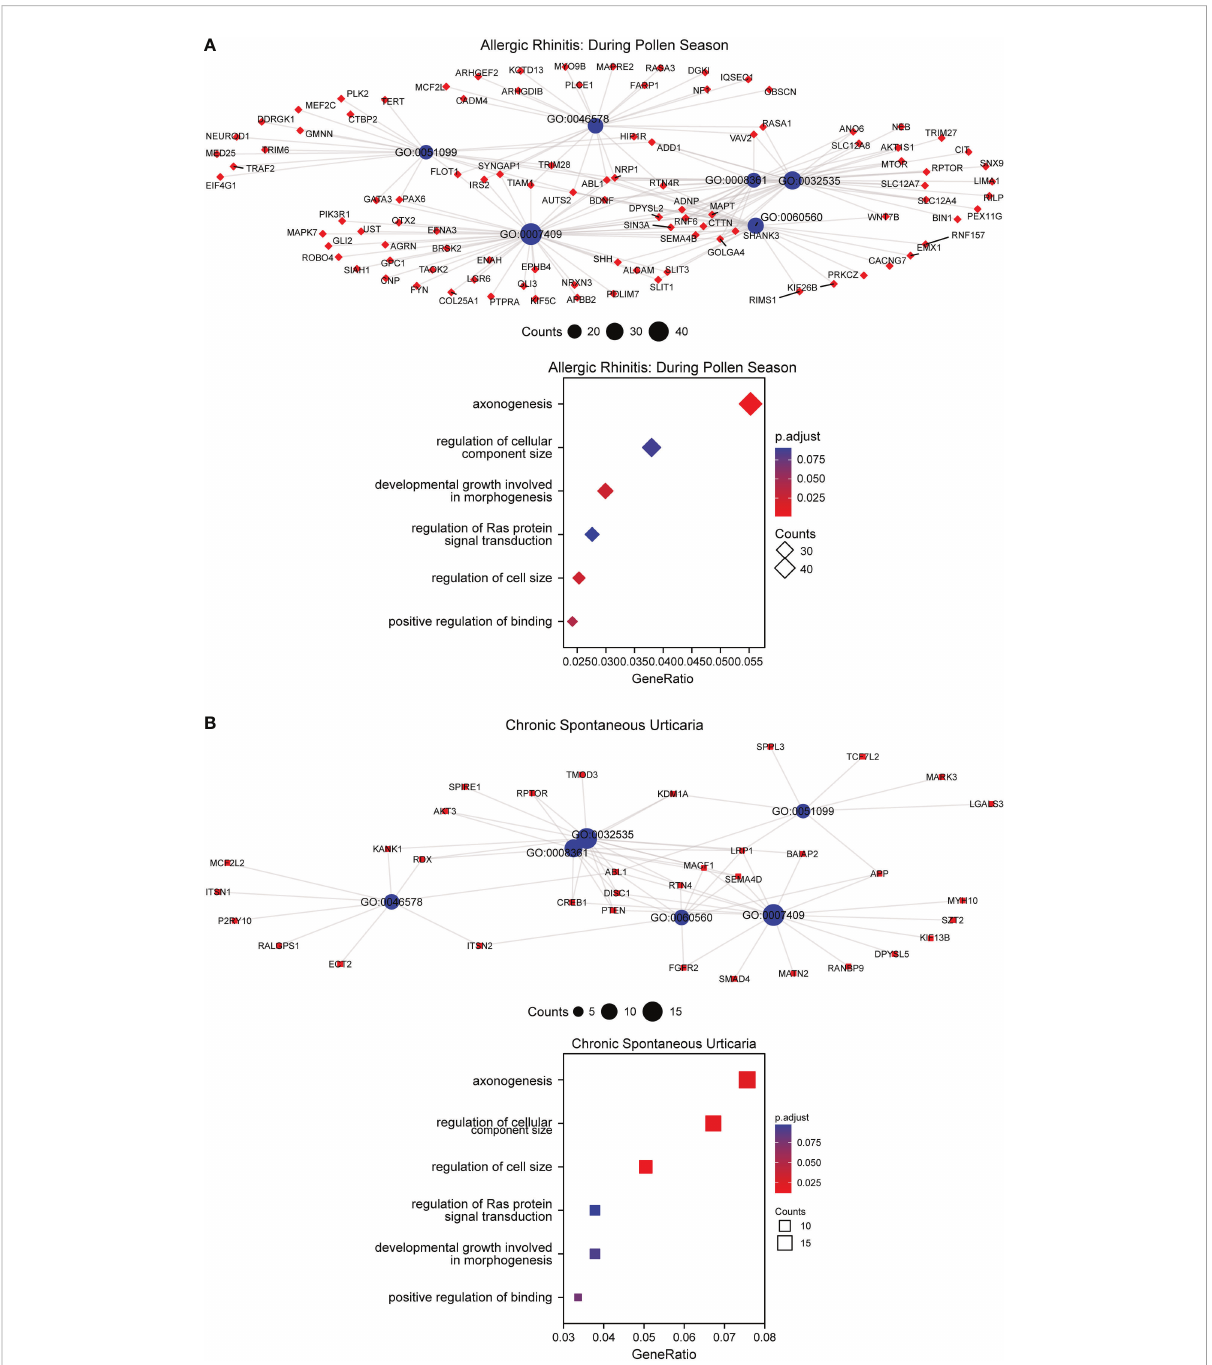
FIGURE 7 GO enrichment analysis of DMGs in AR and CSU patients. (A) GO enrichment analysis of DMGs and bubble chart of regulating pathways in AR patients. (B) GO enrichment analysis of DMGs and bubble chart of regulating pathways in CSU